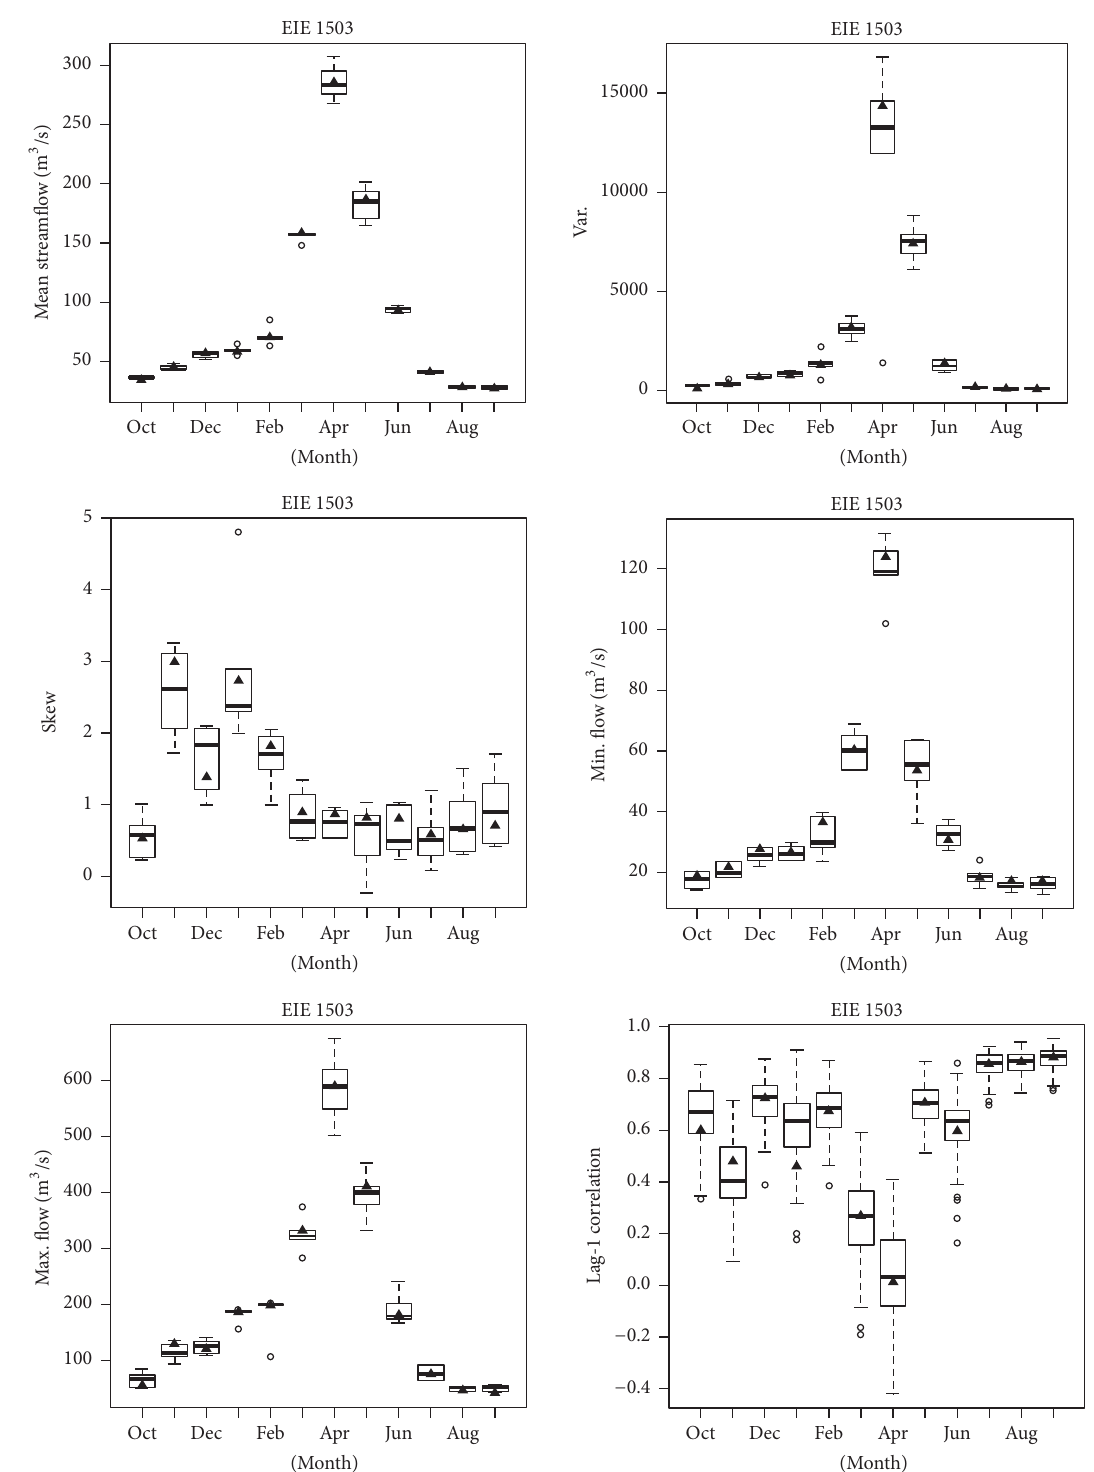
Figure 3: Simulated and observed statistics values from EIE1503 station. The triangle denotes the observed